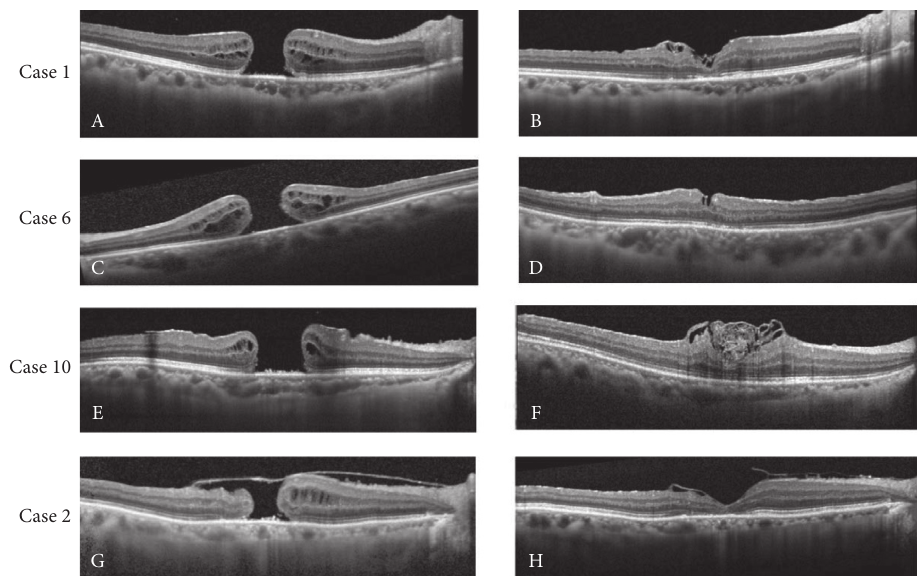
Figure 1: Preoperative and postoperative optical coherence tomographic (OCT) scan images of four cases. (a-b) Preoperative and postoperative OCTscan images of case 1. (c-d) Scan images of case 6. (e-f) Scan images of case 10. (g-h) Scan images of case 2 before and after the second